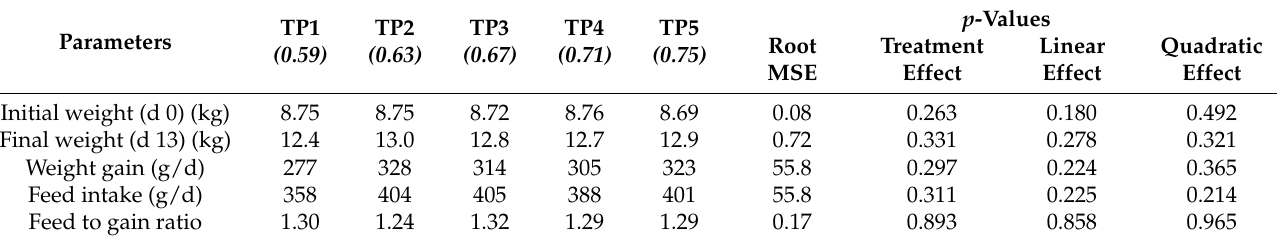
Table 4. Production parameters of piglets between day 0–13 of trial (Pre-starter phase).